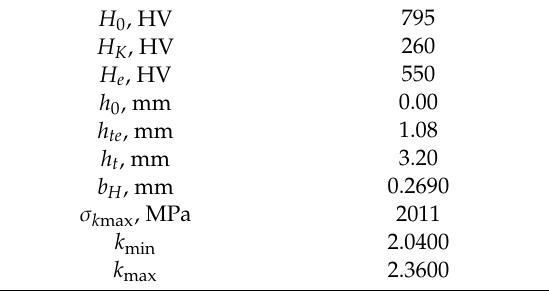
Table 2. Initial data for deep contact strength (DCS) accessing of sample